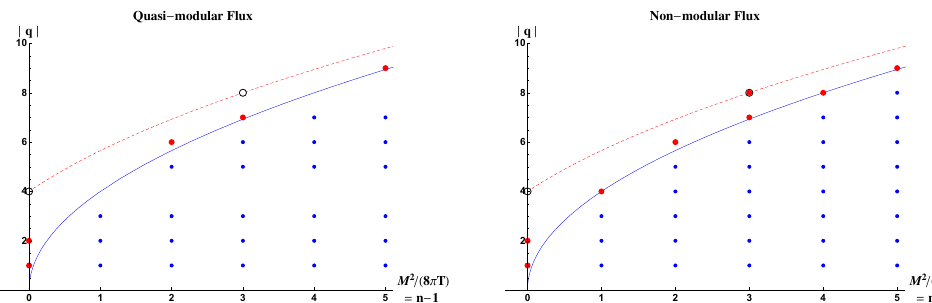
Figure 2 . Same as (cid:12)gure 1, except for quasi-modular (5.19), and generic non-modular background (cid:13)uxes, for which there are fewer and fewer cancellations in the spectrum. Note that in the last case, some super-extremal states do appear to form a sublattice, q = 2 k . However, for other models this is generically not the